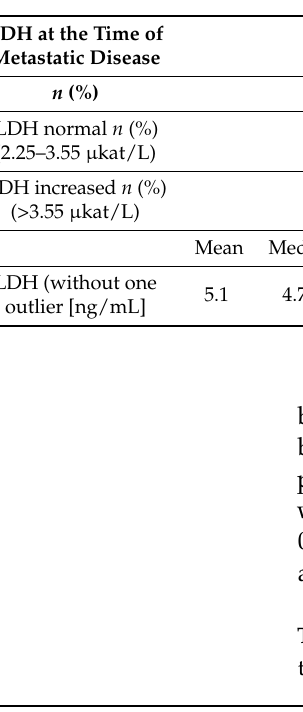
Table 4. Tumor marker LDH in the entire study collective, gender comparison. Normal LDH vs. increased values. One extraordinary outlier with LDH 21.3 µ kat/L was excluded from the calculation as it biases the overall picture in this smaller cohort.